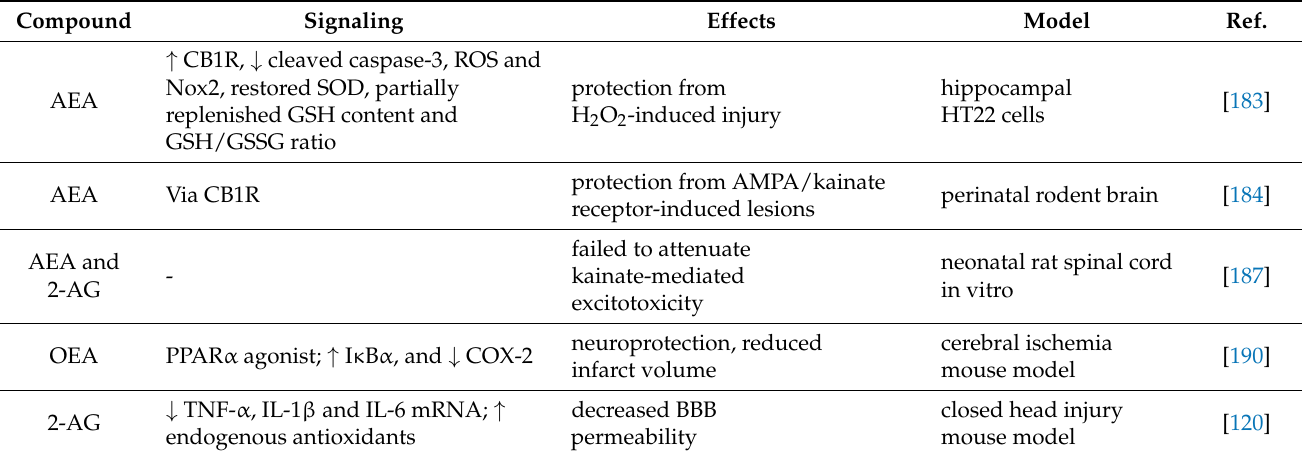
Table 2. Antioxidant and anti-inflammatory effects of endocannabinoids in neurodegenerative